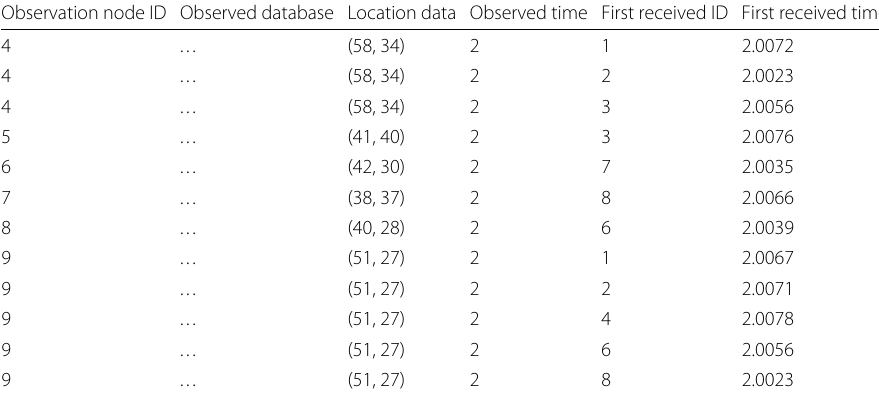
Table 1 Packets are grouped at the second “observation